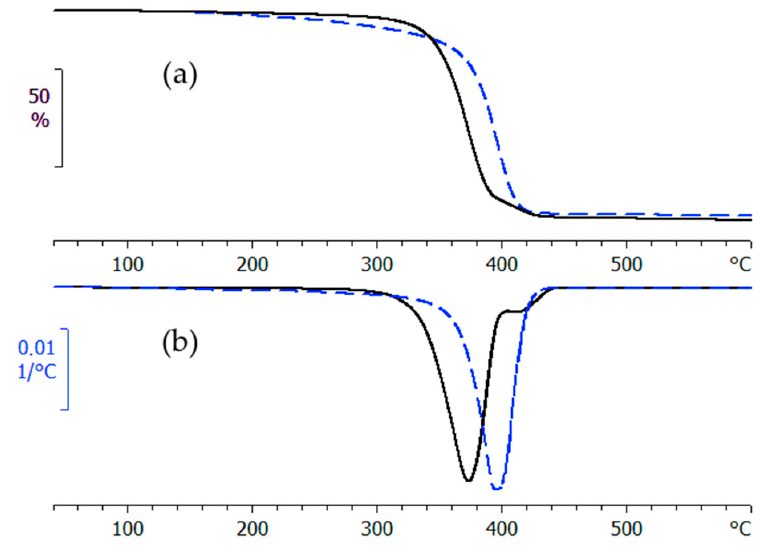
Figure 3. Comparative ( a ) TGA and ( b ) DTGA curves for PEI800 (dashed line, blue) and PEI25000 (full line, black) at the heating rate of 10 °C/min.